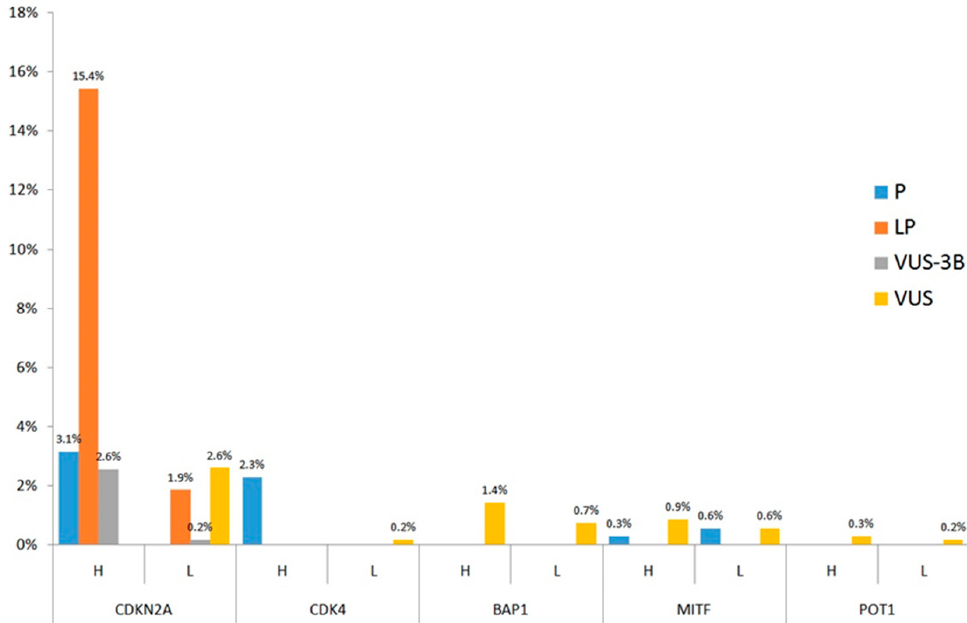
Figure 3. Patients with positive genetic testing results. The proportion of “high significance” and “low significance” patients carrying Pathogenic (P), Likely Pathogenic (LP), VUS-favoring pathogenic (VUS-3B), and VUS variants is shown for each of the analyzed genes. H: high significance patients, L: low significance patients.